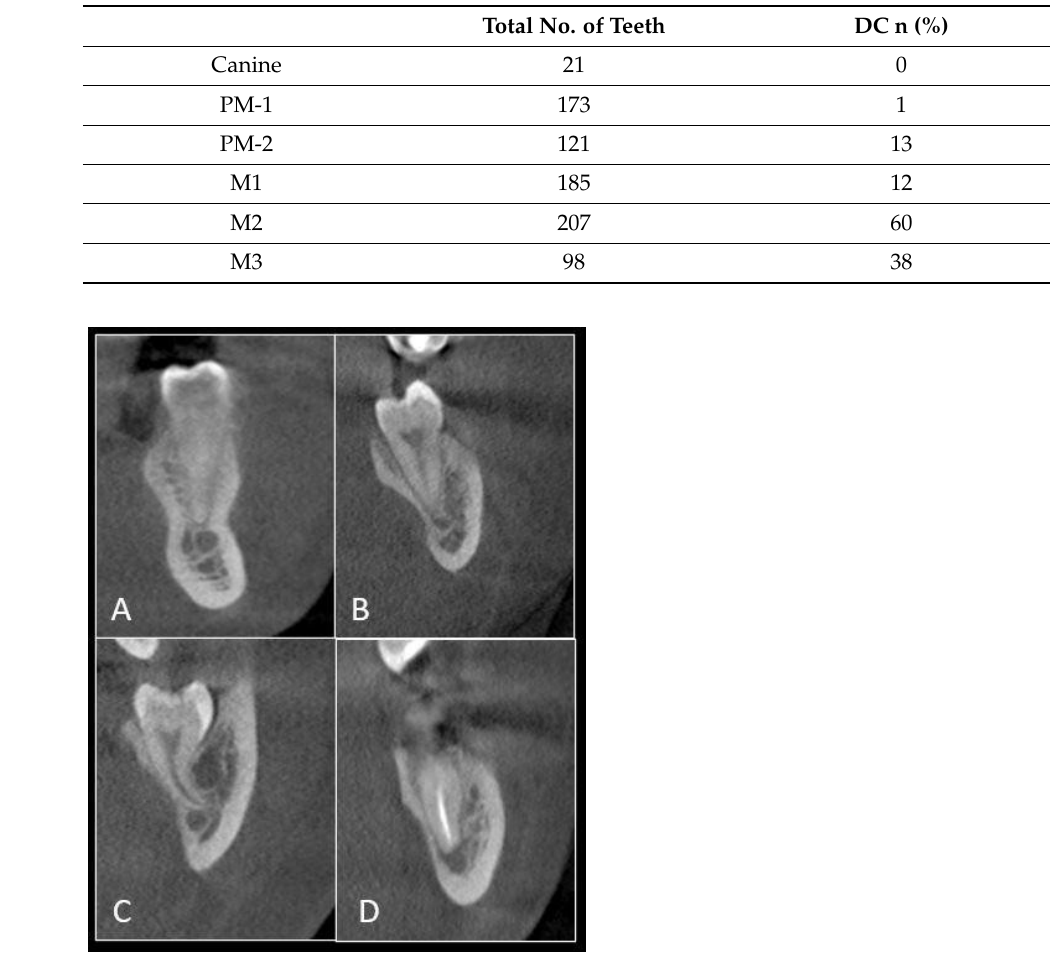
Figure 2. CBCT scan illustrating direct communication of the IAC with the root apex of: ( A ) mandibular premolar, ( B ) mandibular first molar, ( C ) mandibular second molar, and ( D ) mandibular third molar.